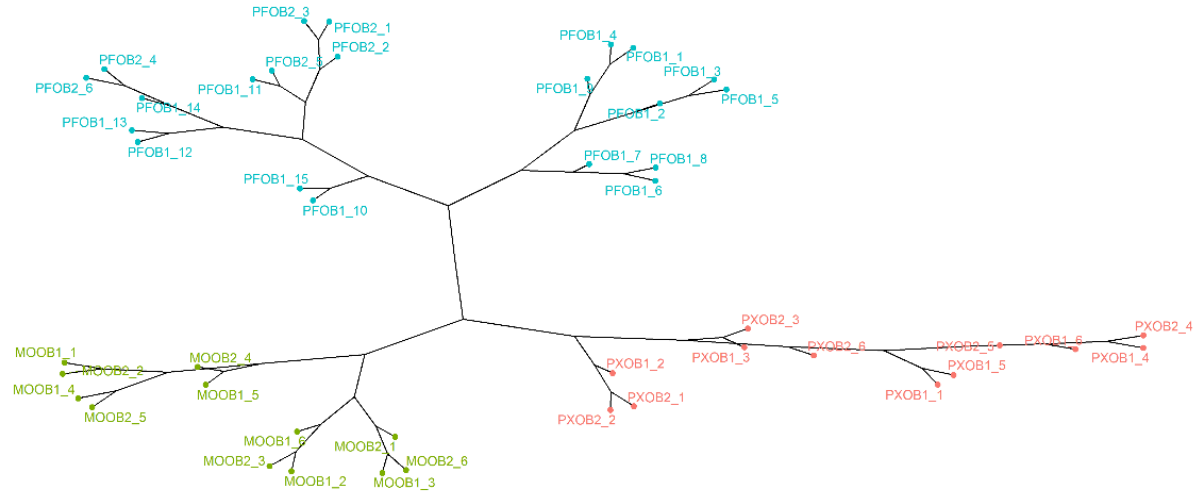
Figure 1. Dendrogram from the HCA analysis combined with Ward’s method with Manhattan distance. The vinegar samples are colored according to their starting wine: blue for PF (Palomino Fino), green for MO (Moscatel), and pink for PX (Pedro Ximénez). OB1: solera and OB2: first criadera ( n = 48).